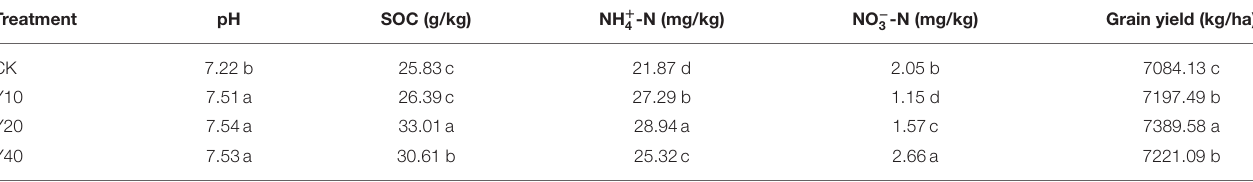
TABLE 2 | Comparison of soil physical and chemical properties and grain yield in different cultivation years of tobacco-rice multiple cropping rotation farmlands.